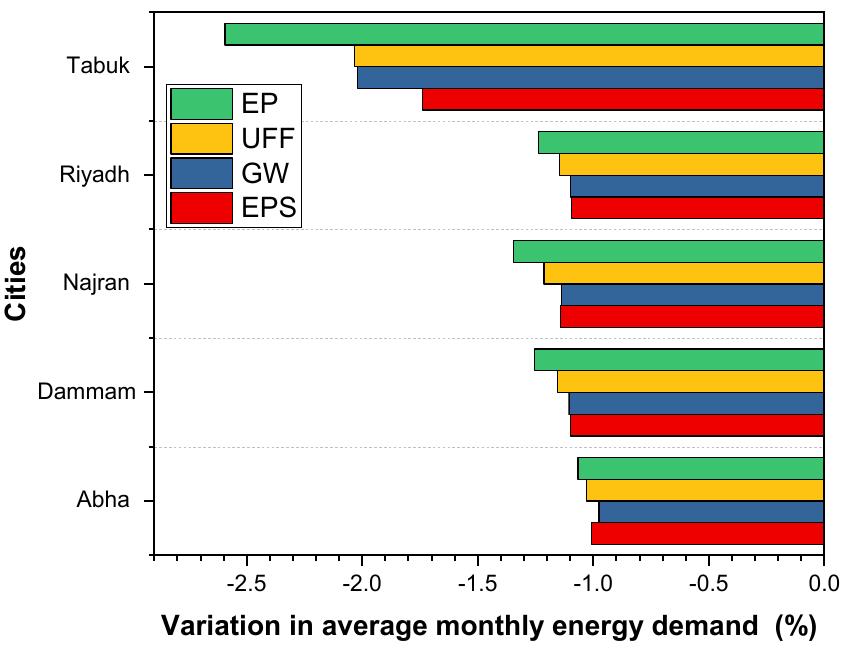
Figure 11. Variation in average monthly energy demand compared to PU base case of the studied cities.